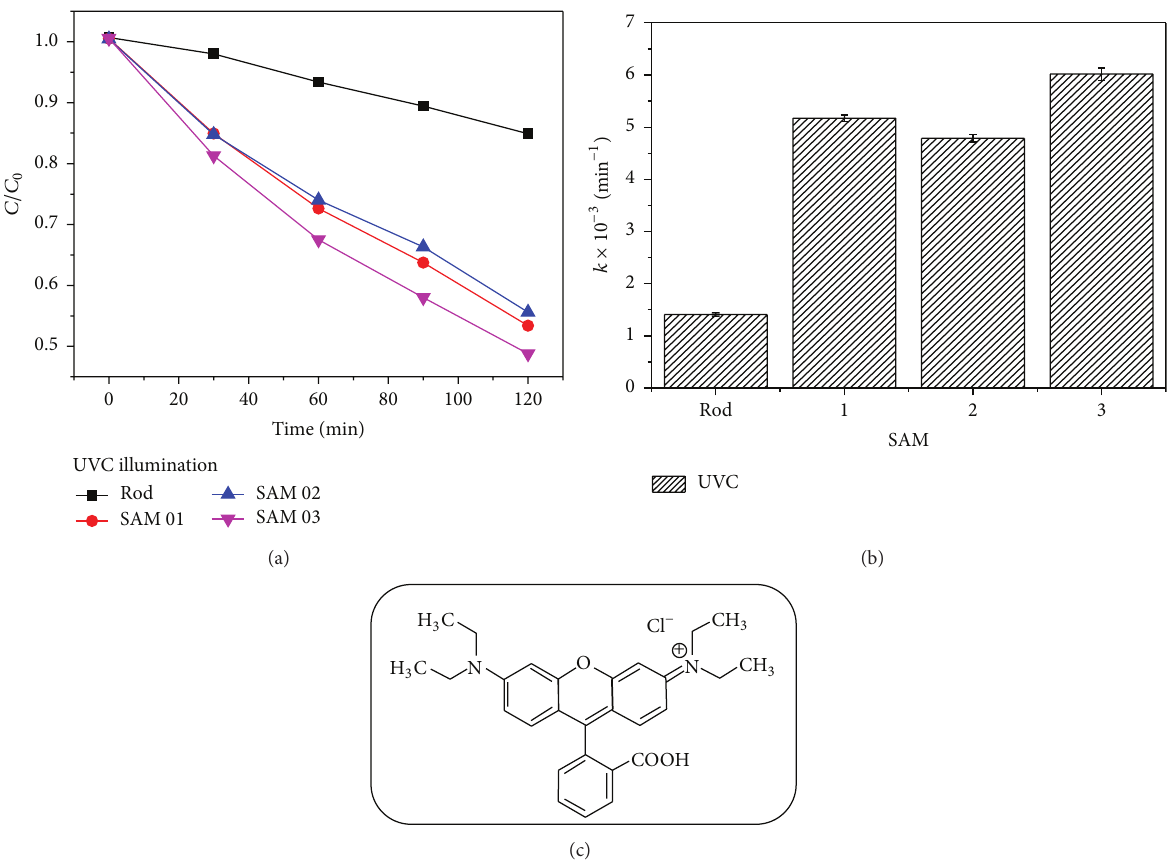
Figure 6: Photodegradation profiles of the Rhod-B solution, using TiO 2 nanoparticles with UVC light (a), column graphic of k values under UVC illumination for Rhod-B (b), and Rhodamine-B molecular structure